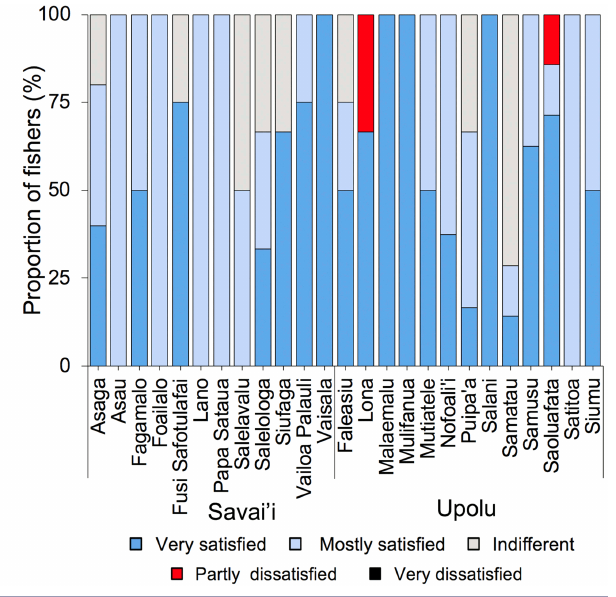
Fig. 5 . Percentages of fishers per village responding to their satisfaction of income from trochus ( Rochia nilotica ; only villages with trochus sales reported by some respondents).